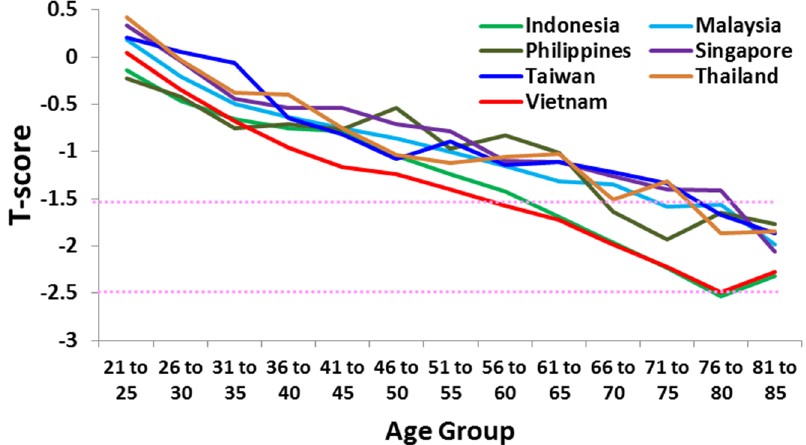
Figure 2. Mean T-scores by age group of men in Singapore (N = 6563), Taiwan (N = 6714), Thailand (N = 3150), Vietnam (N = 35,320), Malaysia (M = 59,458), Indonesia (N = 36,594), and the Philippines (N = 25,527) [16]. Dotted horizontal lines indicate osteopenia ( − 1.5) and osteoporosis ( − 2.5). Men in Europe, the Middle East, and Asia have been shown to be at high risk of hip fractures (defined as >150 fractures per 100,000 men) [17]. In a number of countries, non-traumatic